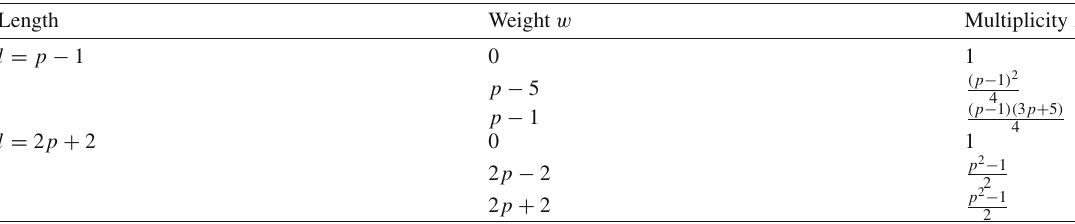
Table 4 The weight distribution of the codes given in Corollary 2.5 and Theorem 2.6 for β ( p ) = 4 Length